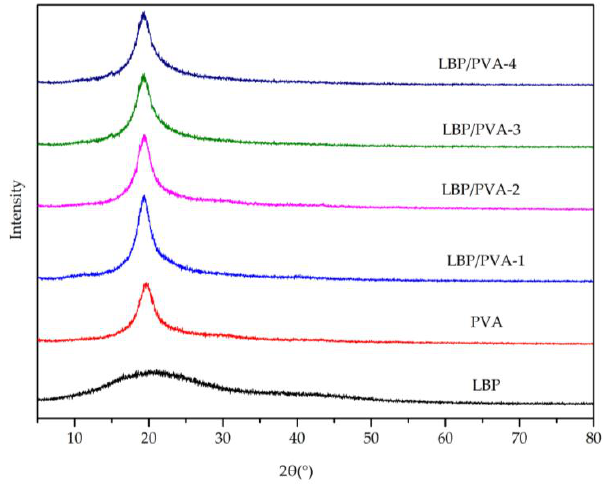
Figure 9. X-ray diffraction (XRD) patterns of the LBT, PVA, and LBT/PVA composite membranes.